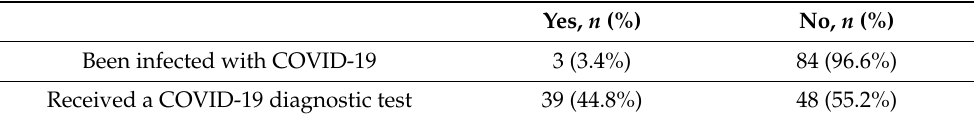
Table 2. Percentage of COVID-19